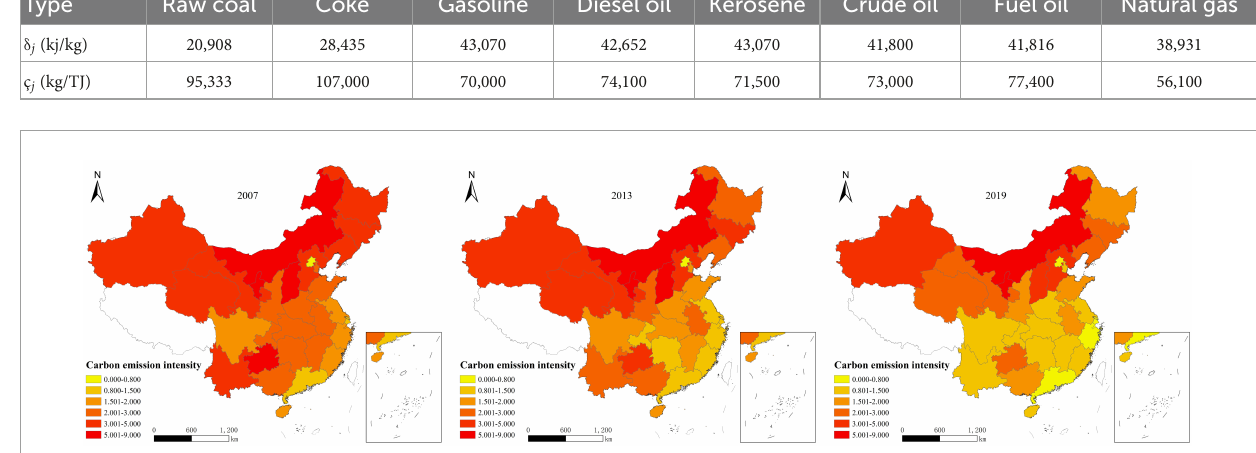
FIGURE2 Spatial distribution of China’s carbon emission intensity in 2007, 2013, and 2019.